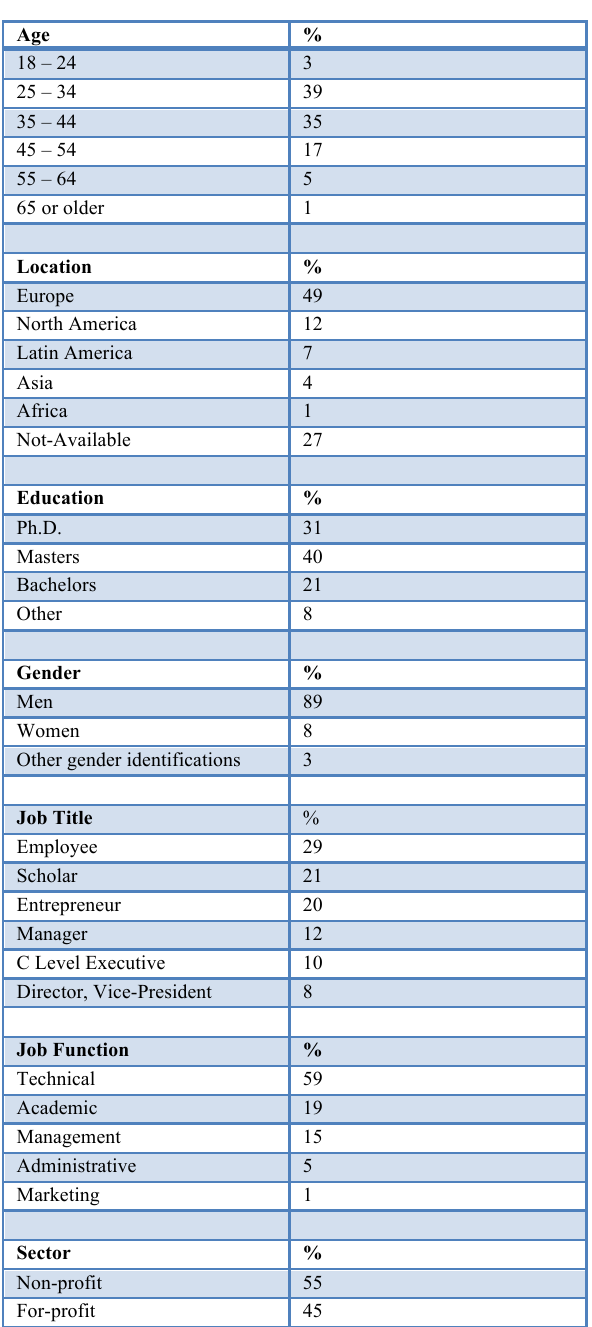
Table 1 : Respondents' basic profiles